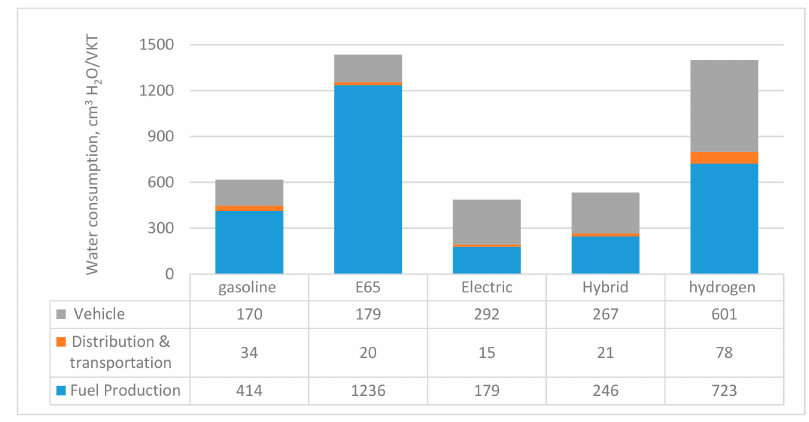
Figure 6. Water consumption impact for di ff erent fuel options (tailpipe emissions are omitted as there are no WC associated with the tailpipe